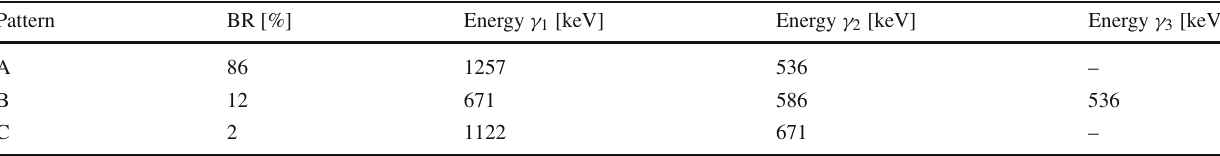
to the ground state. Each row corresponds to a different path 2